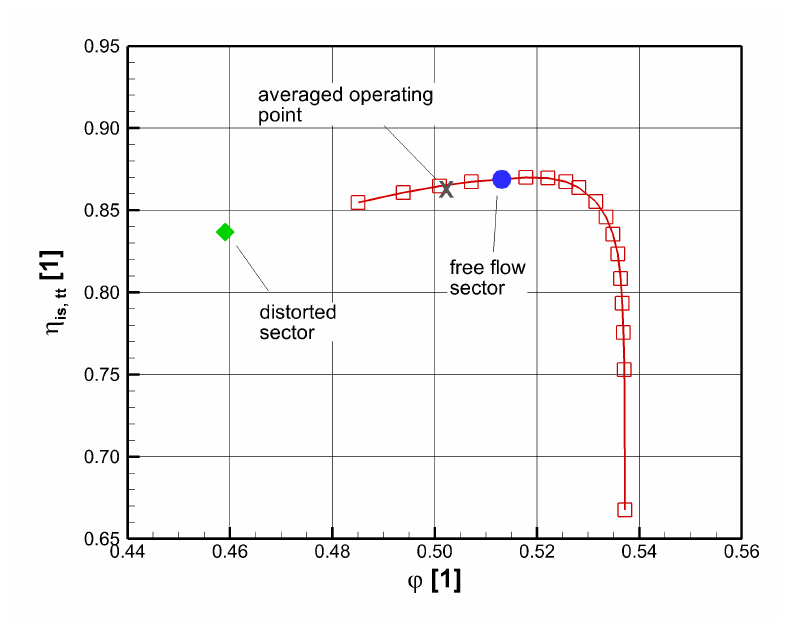
Figure 11. Operating points of the parallel compressors model at preliminary design point.